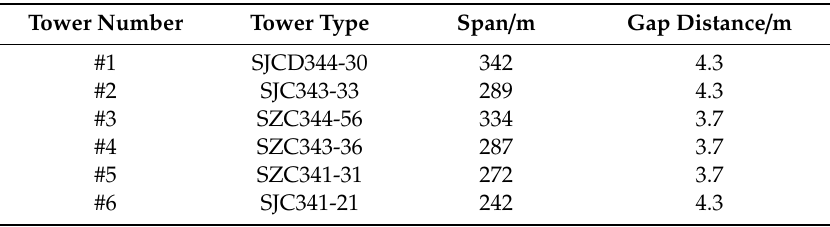
Figure 3. Multi-wave impedance model of transmission tower. Table 4. Parameters of the towers.